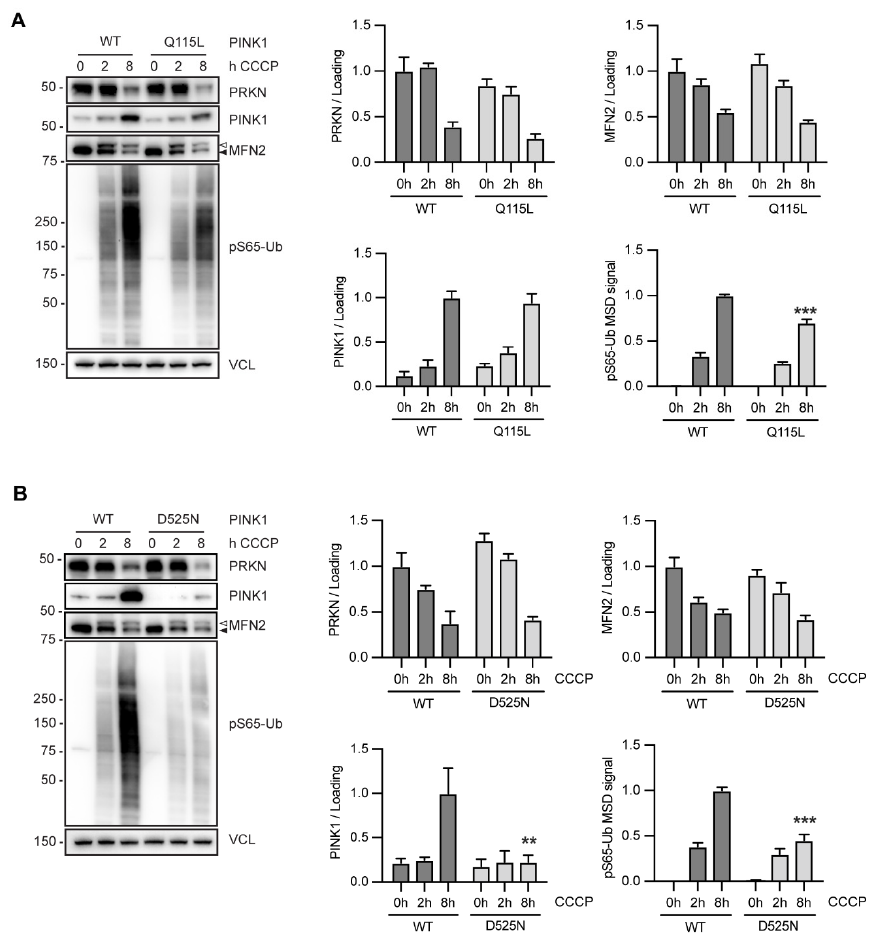
Figure 7. Analysis of PINK1 Q115L and PINK1 D525N in gene-edited neurons. ( A , B ) Differentiated neurons endogenously expressing either PINK1 WT or PINK1 Q115L ( A ) or WT or D525N ( B ) were treated with CCCP for 0, 2, or 8 h, respectively. Western blots were prepared and probed with anti- bodies for PRKN, PINK1, the PRKN substrate MFN2, pS65-Ub and VCL as loading control. pS65-Ub levels were also quantified by MSD sandwich ELISA. Data is shown as the mean ± SEM from three technical ( A ) or biological ( B ) replicate experiments. Statistical analysis was performed using two-way ANOVA with Sidak’s post hoc test to correct for multiple testing (** p < 0.005, *** p < 0.0005). Unmodified MFN2 is indicated by a closed, and ubiquitinated MFN2 by an open arrow- head. ( A ) PINK1, PRKN, and MFN2 levels remain unchanged in gene-edited Q115L, compared to WT, but pS65-Ub levels are significantly decreased. ( B ) PRKN, and MFN2 levels look similar be- tween WT and gene-edited D525N, but PINK1 protein levels as well as pS65-Ub levels are signifi- cantly decreased in the mutant cells compared to controls.